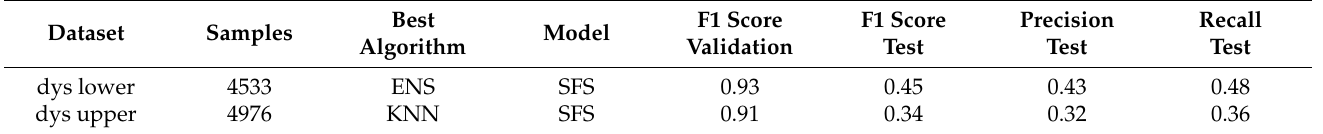
Table 6. Overview of best generalized model per dataset.